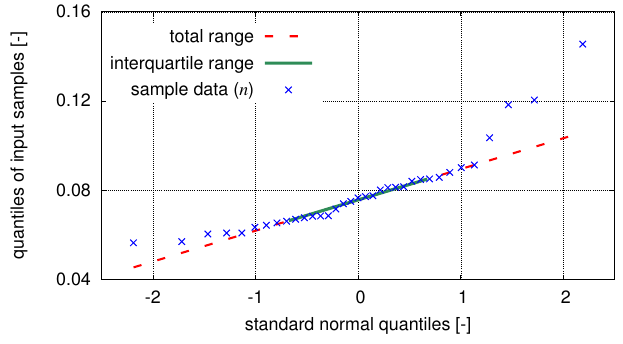
Figure 21. Quantile-quantile plot of sample data n .